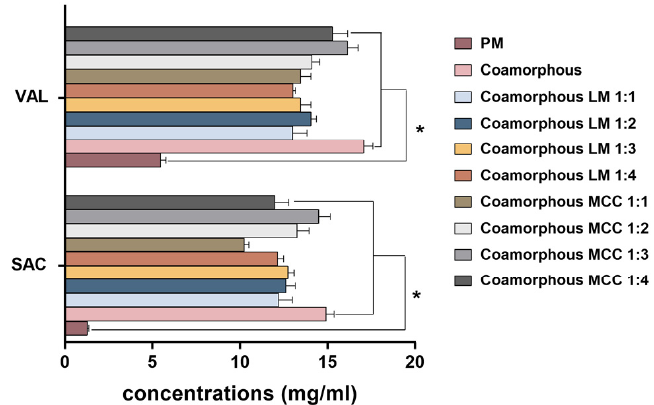
Figure 5. The equilibrium solubility of spray-dried preparations and physical mixtures (PM) in 50 mM pH 6.8 PBS ( n = 3). Statistical analysis was determined using one-way ANOVA (*: p <